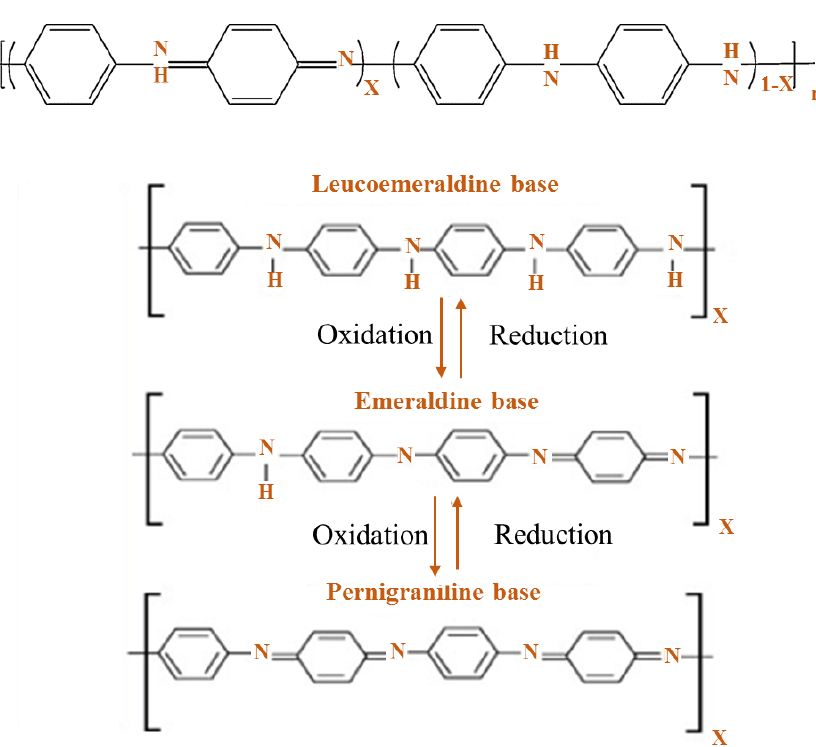
Figure 2. Basic PANI in three dissimilar types (0 ≤ x ≤ 1). Reproduced from Prog. Polym. Sci, Vol 23, Gospodinova, N.; Terlemezyan, L., Conducting polymers prepared by oxidative